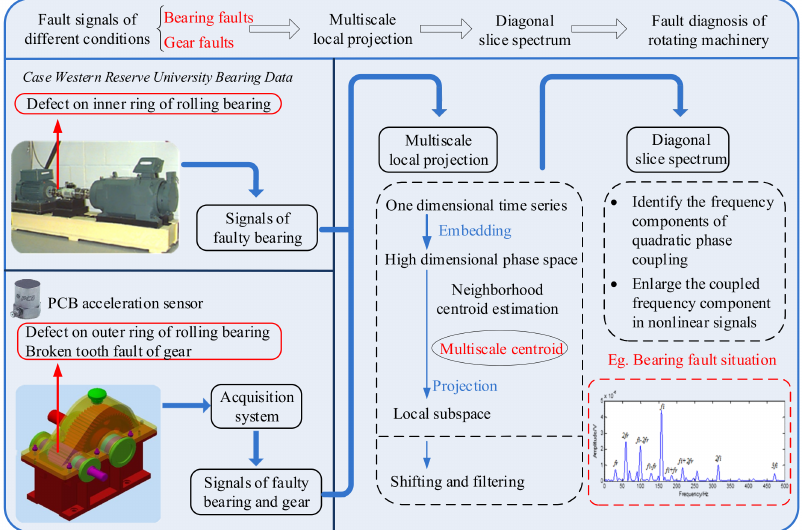
Figure 5. The proposed fault diagnosis scheme of rotating machinery based on the multiscale local projection method and diagonal slice